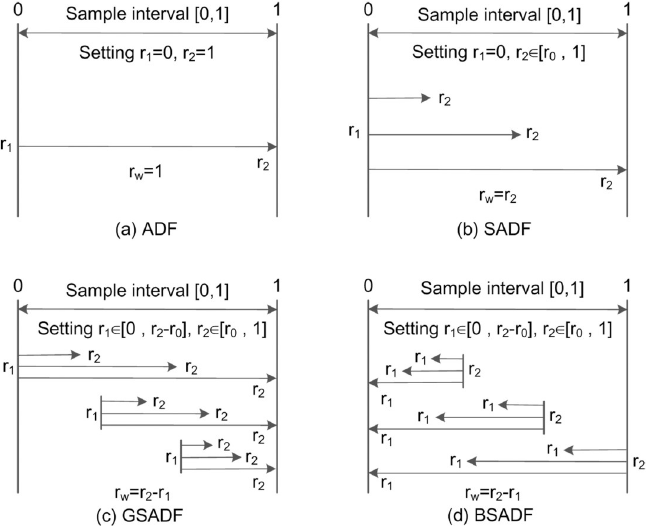
Fig 2. Sample sequences of the four tests. This figure compares the sample sequence selections for (a) ADF, (b) SADF, (c) GSADF, and (d) BSADF, where r 0 , r 1 , r 2 , r w are the initial window width, start point, end point, and recursive window width of rolling samples,